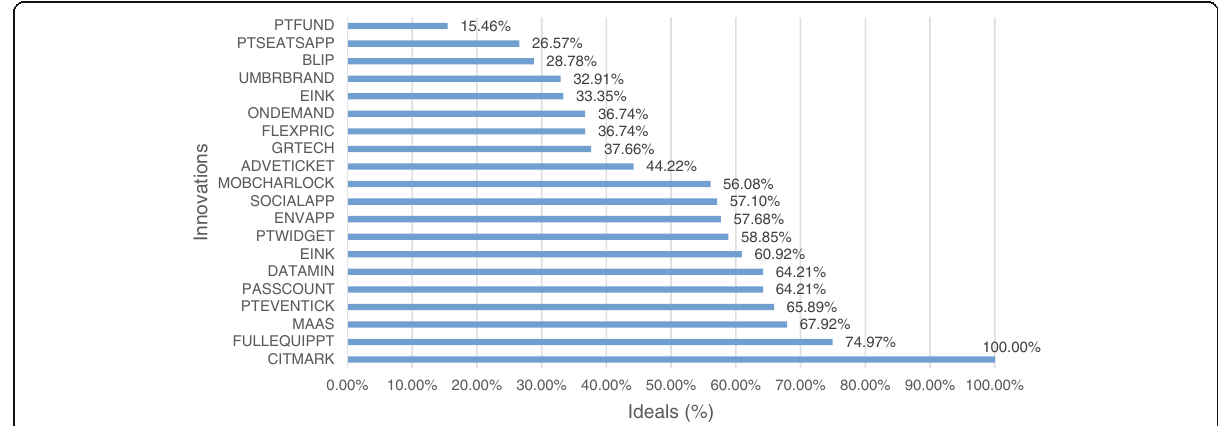
Fig. 4 Ranking of innovations with respect to Feasibility (Ideals